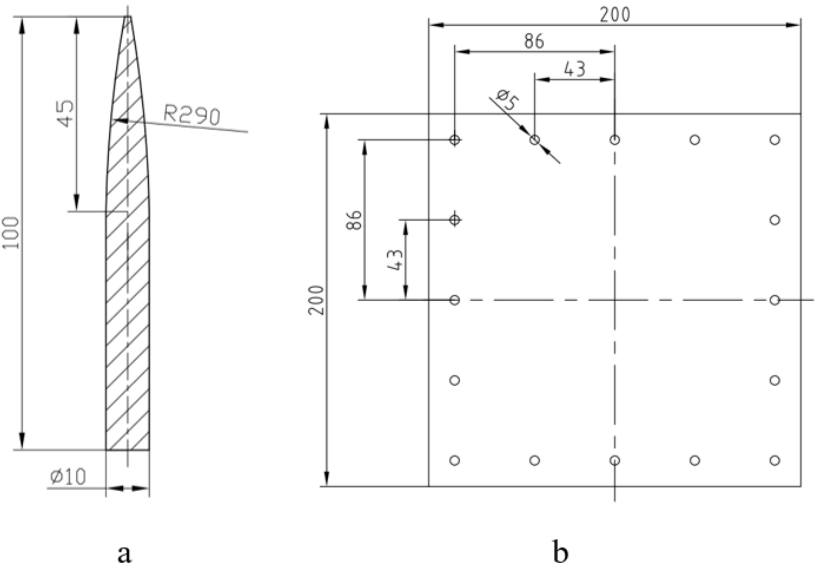
Figure 2. Structural model. ( a ) Harpoon, ( b ) Target plate.